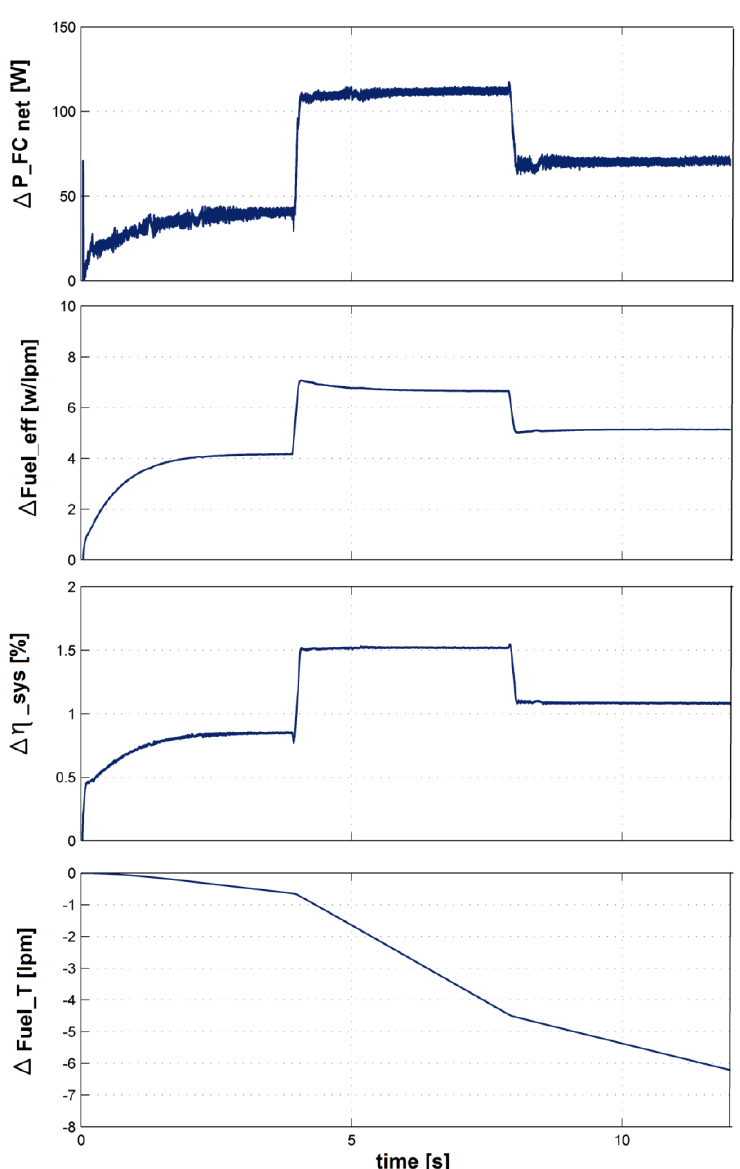
Figure 11. The behavior of the performance indicators for the FC HPS under 6.25 kW LC (using RTO1 strategy with k fuel = 25).